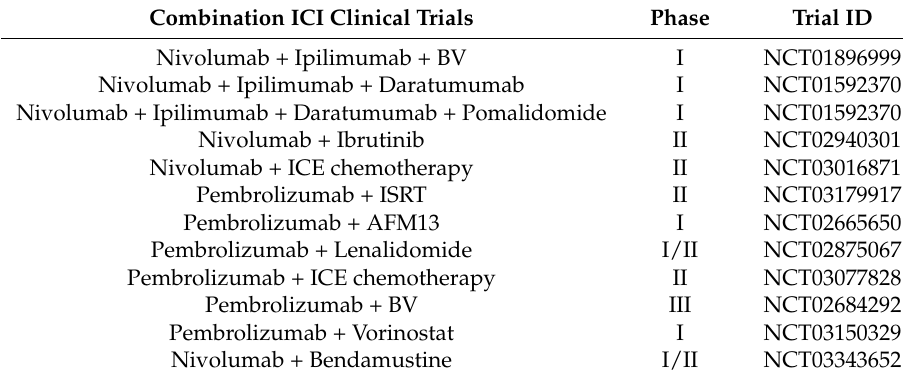
Table 2. Summary of all ongoing trials using immune checkpoint inhibitors in combination with other agents in rrHL as of March 1st, 2018. BV = Brentuximab Vedotin; ICE = Ifosfamide, Carboplatin, and Etoposide; ISRT = Involved site radiation